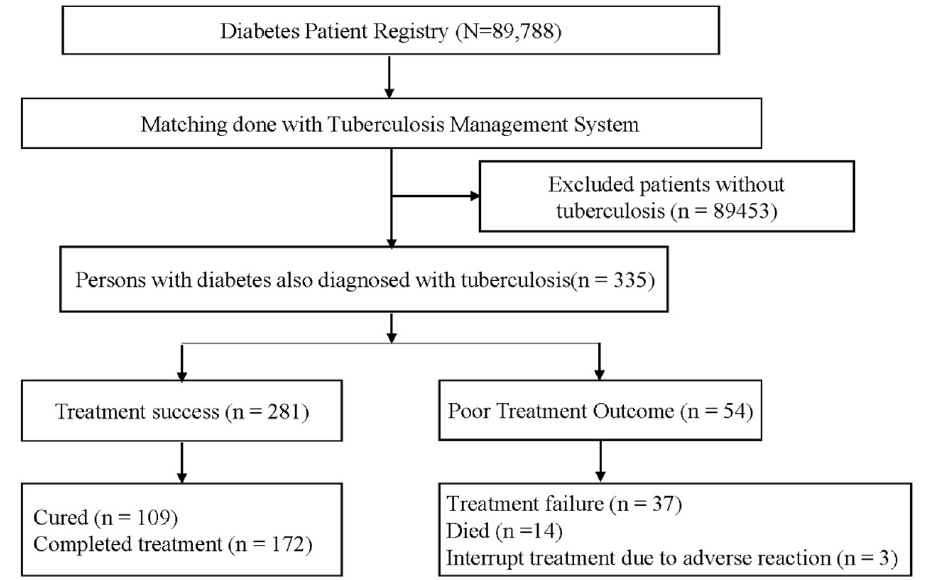
Figure 1. Flowchart for the treatment outcomes of tuberculosis patients with diabetes after treatment completed in Jiangsu province,